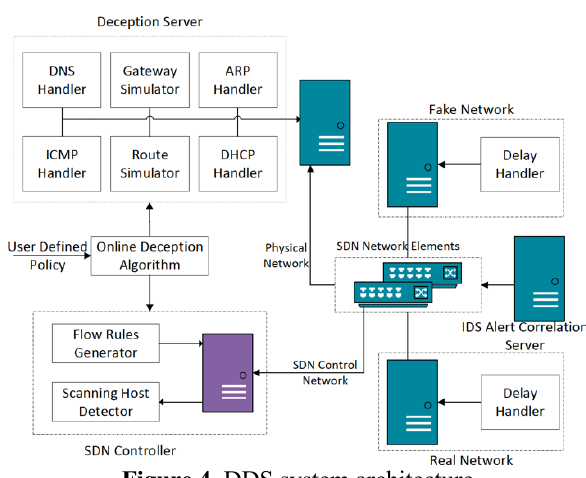
Figure 4. DDS system